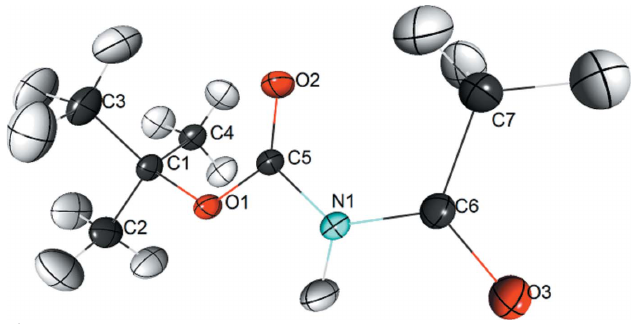
Figure 1 View of molecule (I), showing the atom-labelling scheme. Displacement ellipsoids are drawn at the 50% probability level.